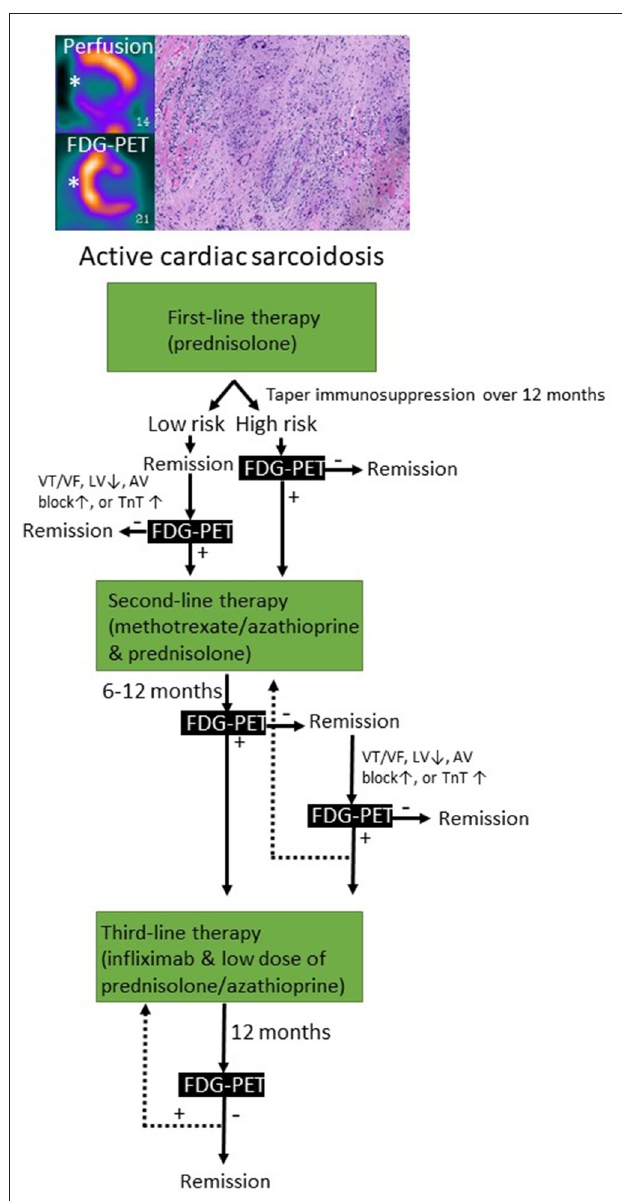
FIGURE 4 | Immunosuppressive treatment strategies used for cardiac sarcoidosis based on clinical and imaging-based monitoring. FDG-PET, fluorodeoxyglucose positron emission tomography; VT/VF, ventricular tachycardia/ventricular fibrillation; LV, left ventricular ejection fraction; TnT,